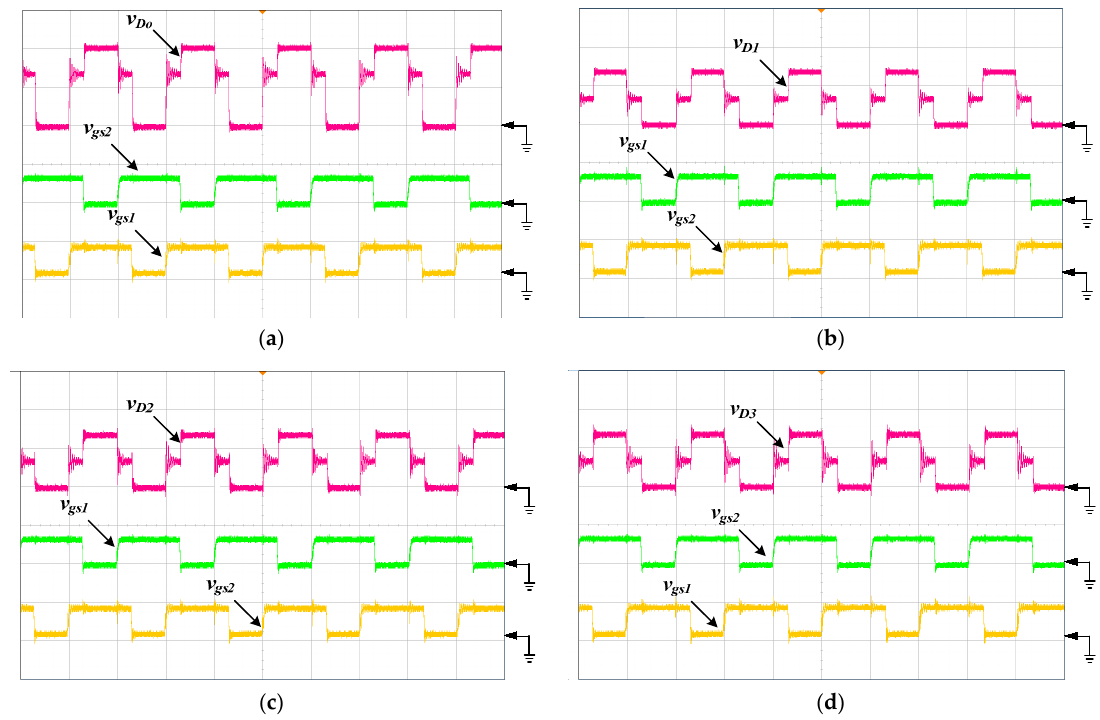
Figure 5. Experimental waveforms of diodes: ( a ) v D o ( v D o : 100 V/div, v gs 1 and v gs2 : 20 V/div, time: 5 μ s/div); ( b ) v D 1 ( v D 1 : 200 V/div, v gs1 and v gs2 : 20 V/div, time: 5 μ s/div); ( c ) v D 2 ( v D 2 : 100 V/div, v gs1 and v gs2 : 20 V/div, time: 5 μ s/div); ( d ) v D 3 ( v D 3 : 100 V/div, v gs1 and v gs2 : 20 V/div, time: 5 μ s/div).